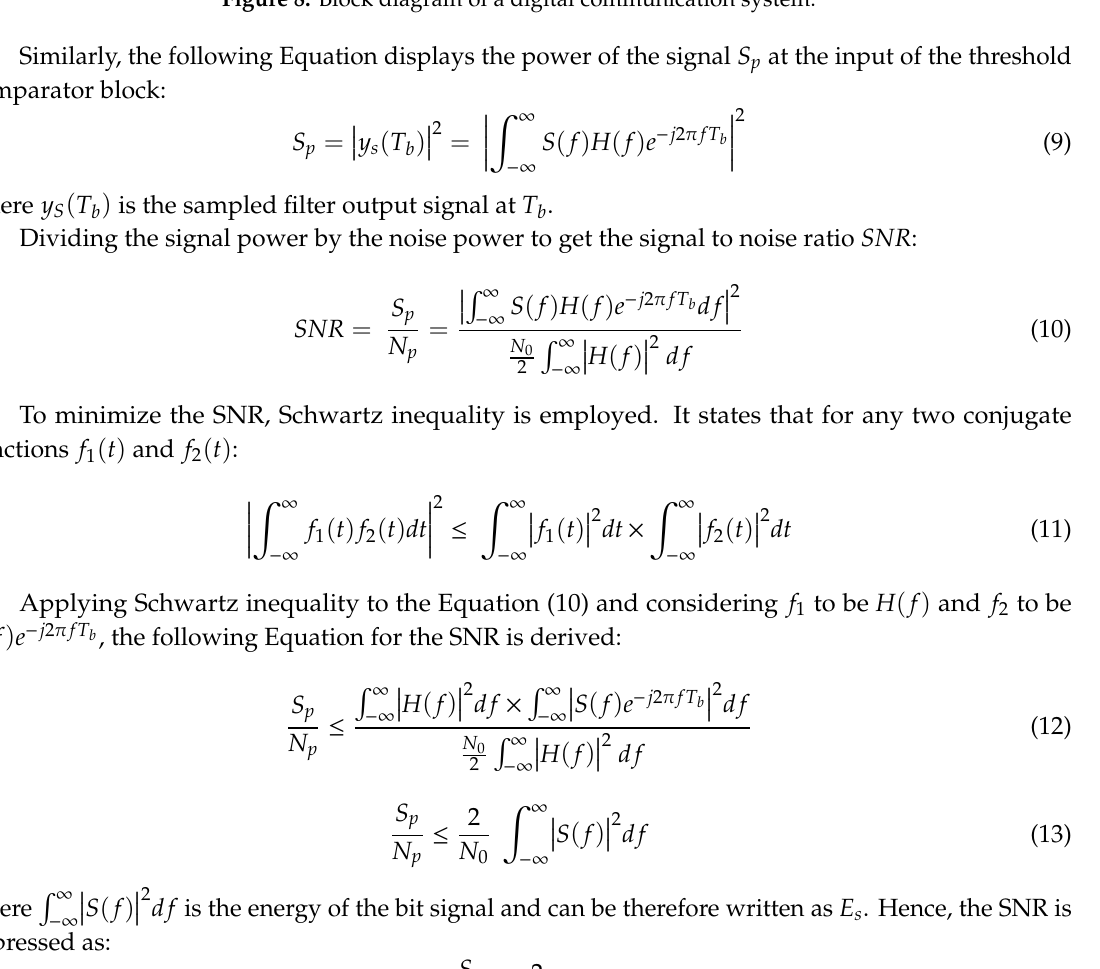
Figure 8. Block diagram of a digital communication system.